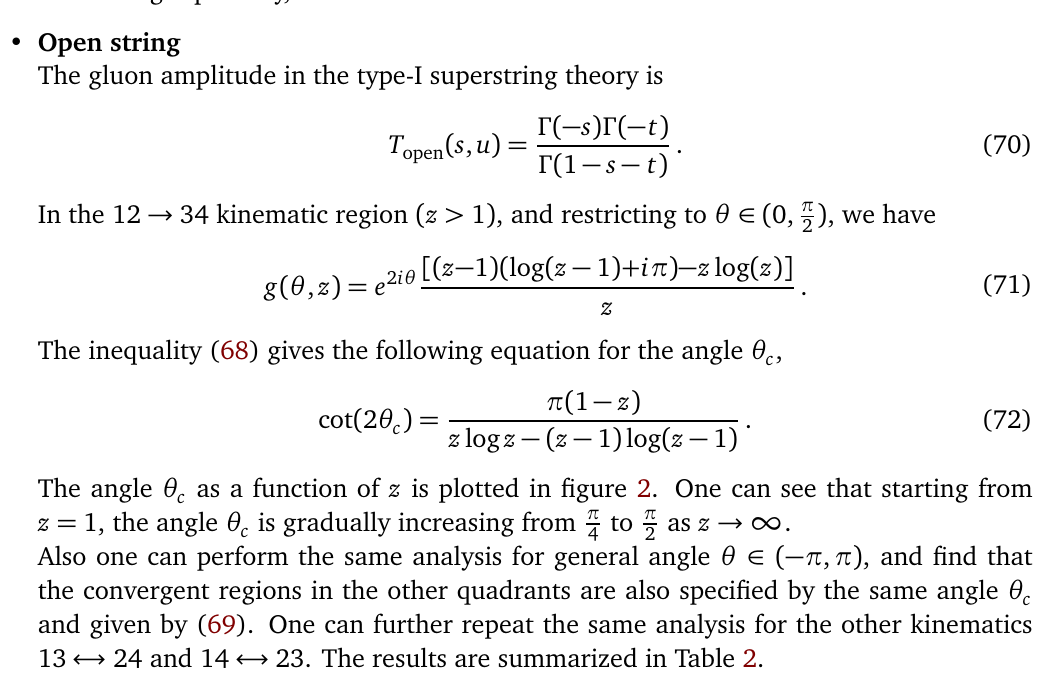
Table 2: Characteristic angles in open